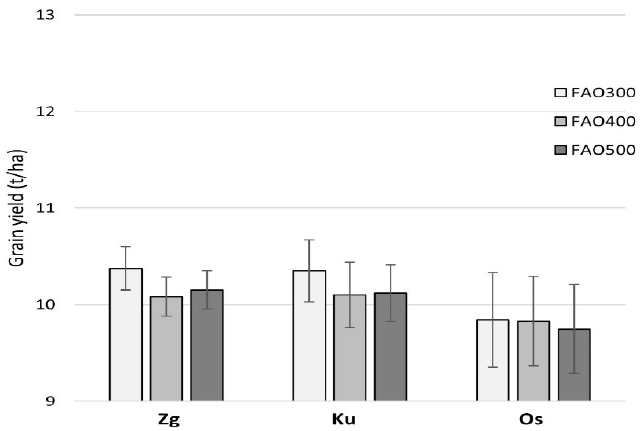
Figure 4. The best linear unbiased predictions of random Location effects (L_BLUPs) with corresponding standard errors in VCU trials in maize genotypes belonging to three maturity groups FAO 300, FAO 400, and FAO 500.